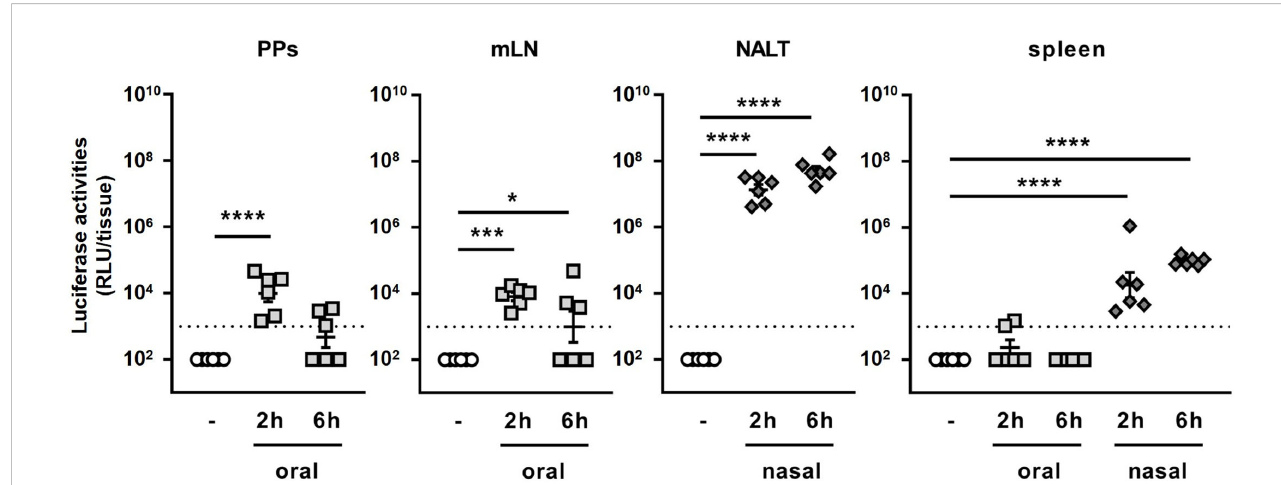
FIGURE 3 Dynamics of antigen bound to BLPs after oral and nasal administration. The luciferase activities in lymphoid tissues (PPs, mLN, NALT and spleen) at 2 or 6 h after oral or nasal administration of 2 × 10 9 BLP-NanoLuc. Data were expressed as the mean ± SEM of whole tissue (n=6). Each symbol represents an independent mouse. Dotted line indicates the detection limit. *, p<0.05; ***, p<0.001; and ****, p<0.0001; one-way ANOVA followed by Dunnett ’ s multiple comparison